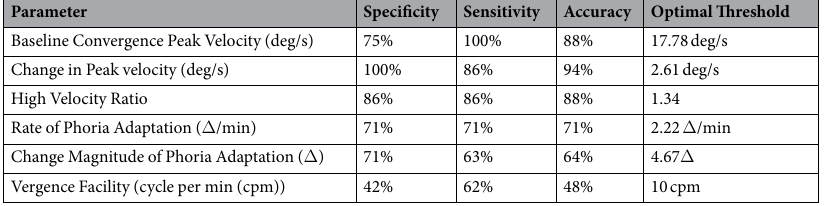
Table 3. Specificity, sensitivity, accuracy and the optimal threshold for the following parameters